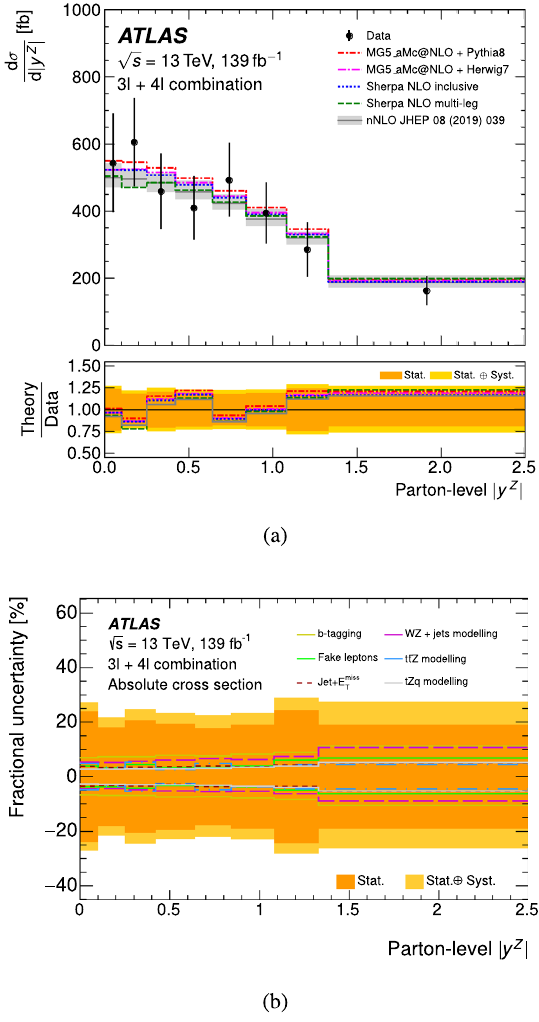
Fig. 11 a Absolute differential t ¯ tZ cross sections and b the relative contributions from different categories of systematic uncertainties per bin measured at parton level as a function of the absolute rapidity of the Z